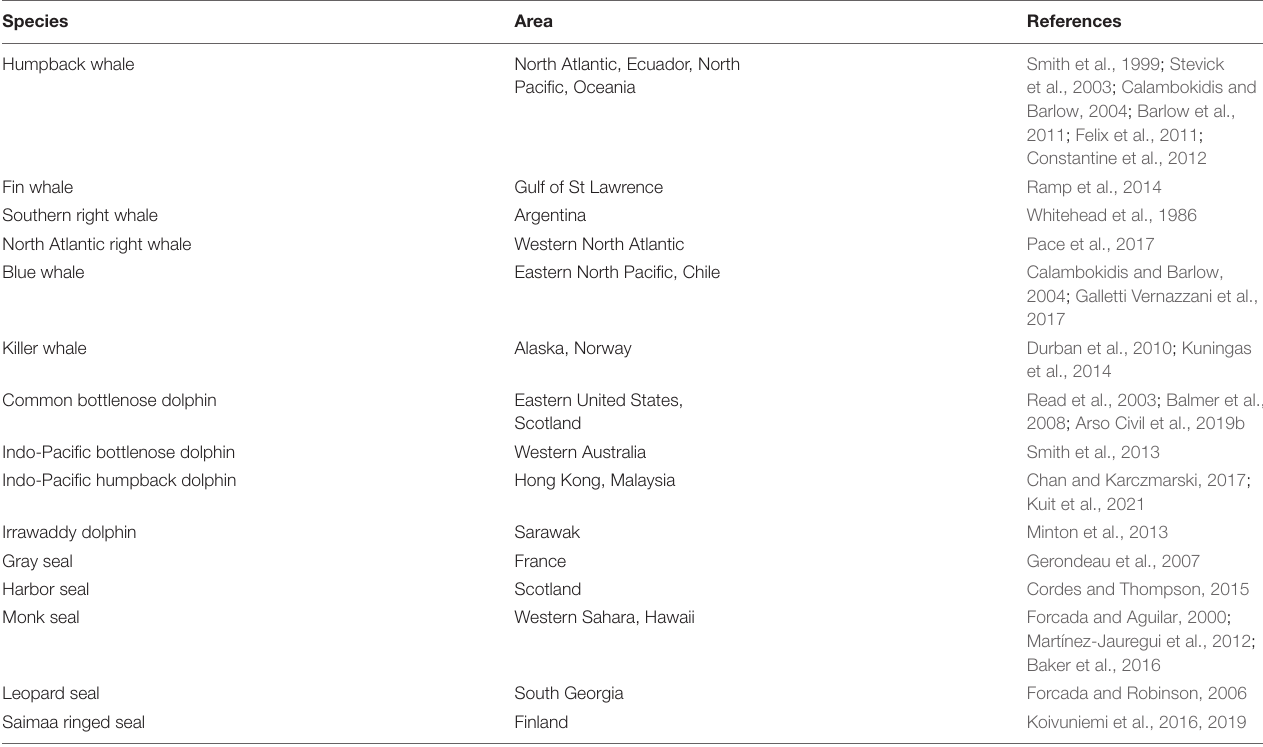
TABLE 2 | Example studies applying mark-recapture analyses to photo-identification data to estimate the abundance of cetacean and pinniped